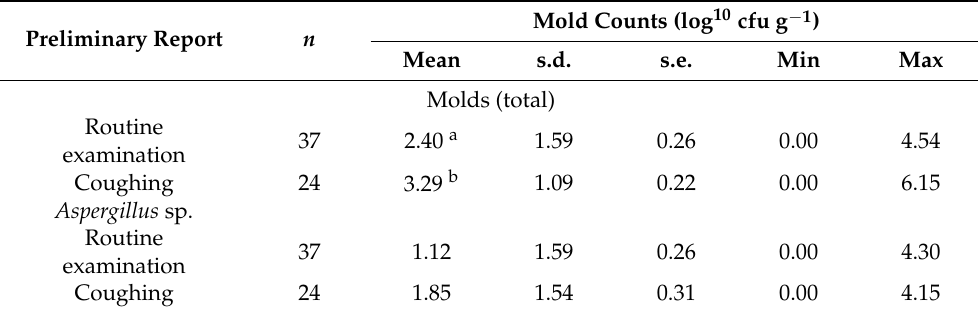
Table 6. Quantitative determination (log 10 cfu g − 1 as fed) of mold counts in concentrate samples without and with occurrence of coughing after feeding ( p =